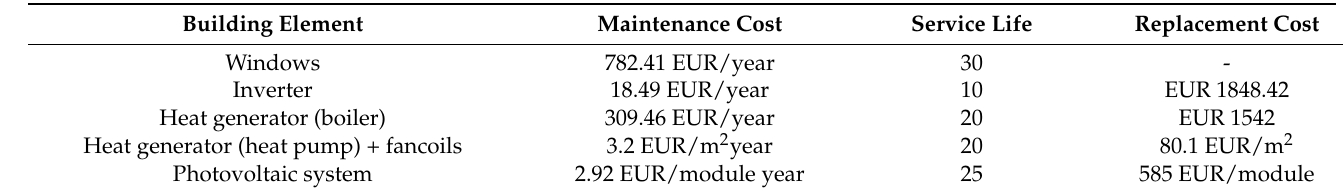
Table 3. Maintenance and replacement costs for the building elements characterized by a lower service life span than the 30 years considered for cost-optimal analysis. Data in the table refers to Poliziano school. The same was done for the other building (Rodari school). The references for the following cost are